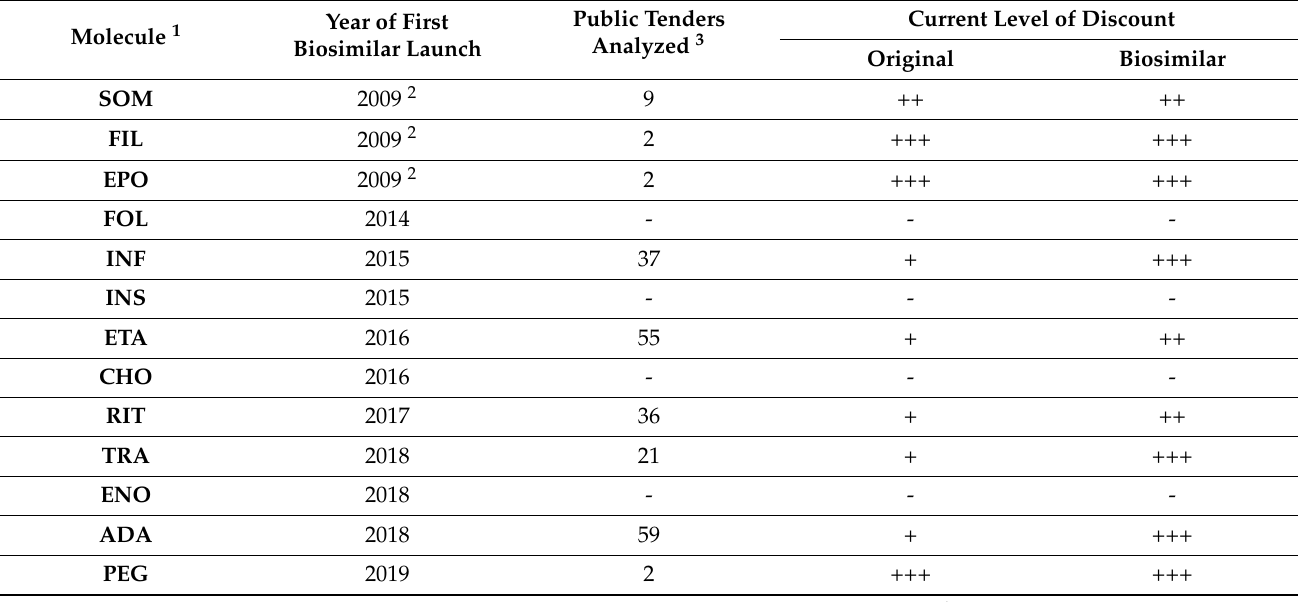
Table 4. Level of discount on price per molecule.